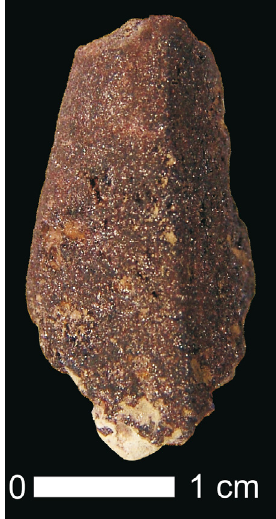
Figure 7. Hohle Fels, hematite fragment, excavated 2009. Photo: M. Malina. A red ochre chalk piece (Find 102/555.1) was found in 2009 in AH IIaf (Conard & Malina, 2010) and measures 0.8 x 0.7 x 0.6 cm (Fig. 8). It shows three worked surfaces with highly weathered scoring or incision marks, flanked by micro-striations. Henshilwood et al. (2001, p. 433) define this artefact type as a “crayon”,